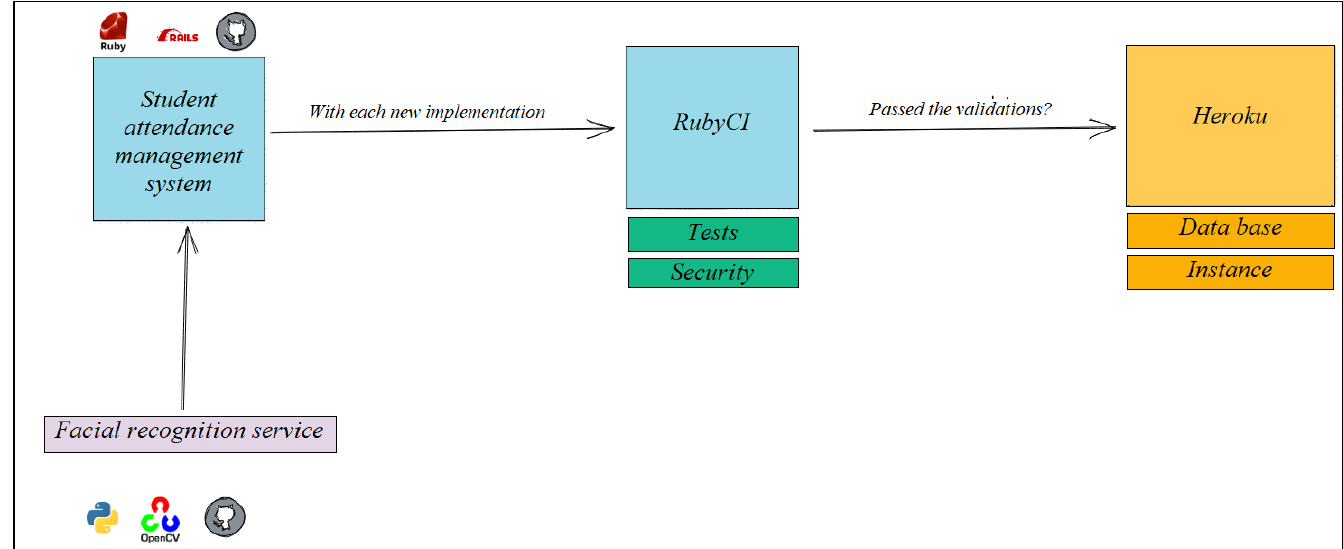
Figure 3: Project development